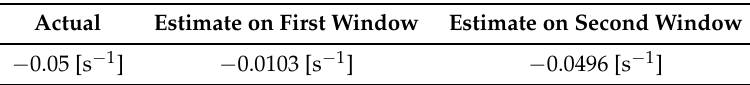
Table 3. Estimates of the damping